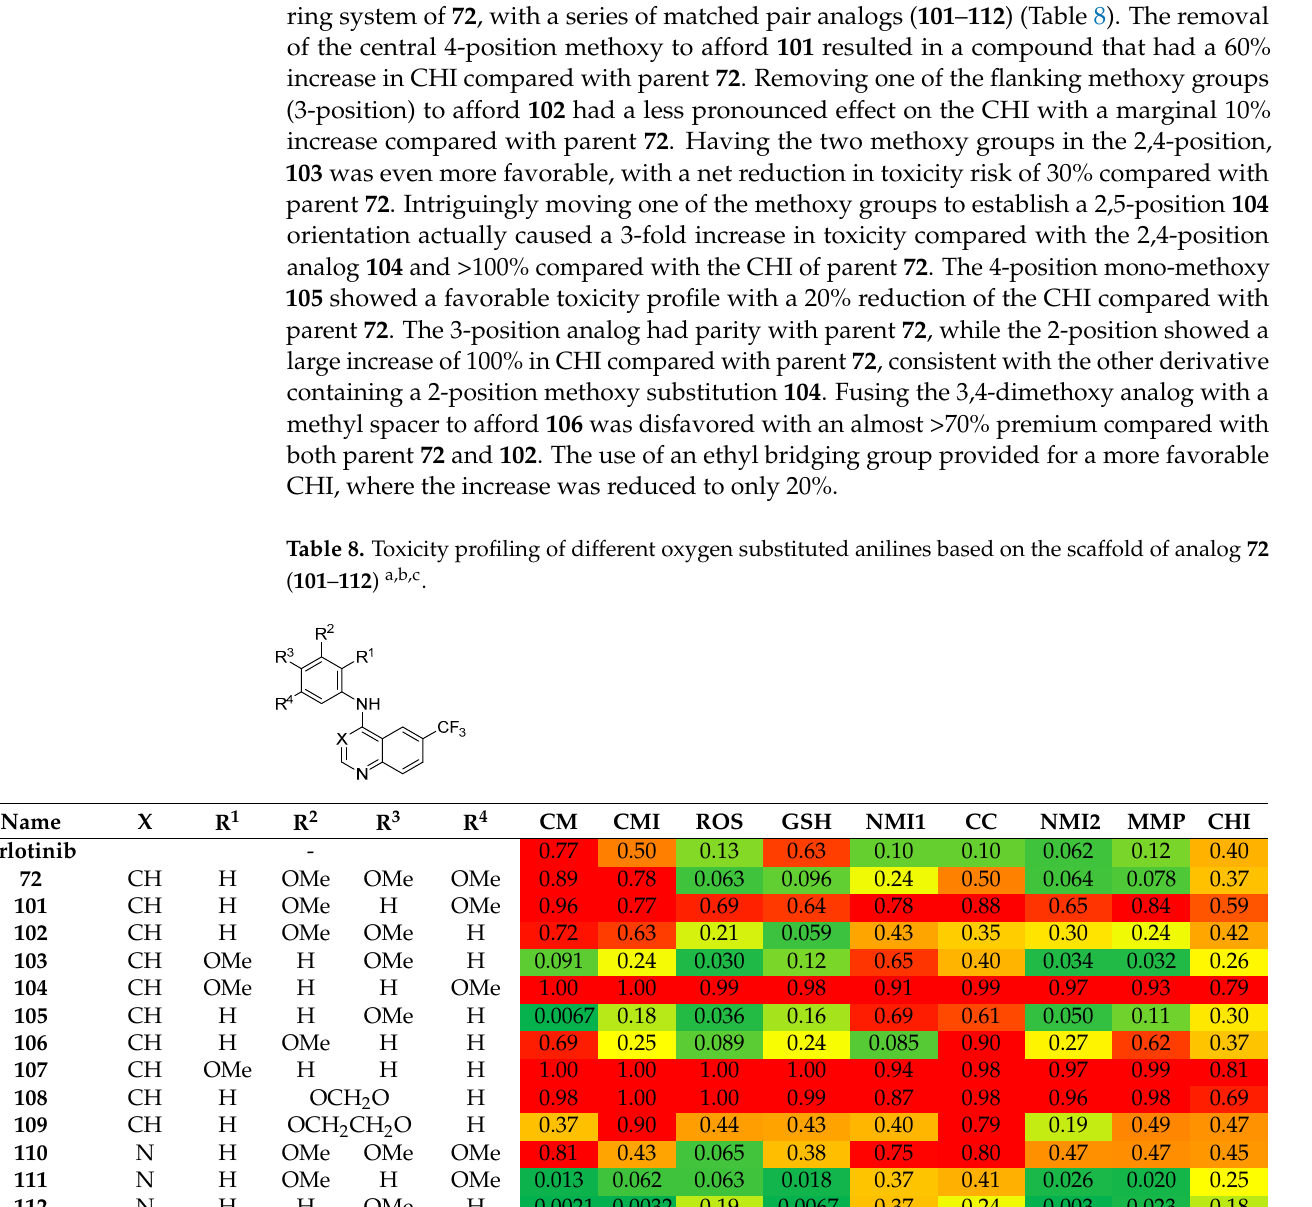
a Abbreviations from columns left to right. CM: Cell morphology; CMI: Cell membrane integrity; ROS: Reactive oxygen species; GSH: Glutathione; NMI1: Nuclear membrane integrity 1; CC: Cell Cycle; NMI2: Nuclear membrane integrity 2; MMP: Mitochondrial membrane potential; CHI: Cell Health Index. b Traffic light colouring matching classifier values (Red–Green: high toxicity risk–low toxicity risk). c all n =